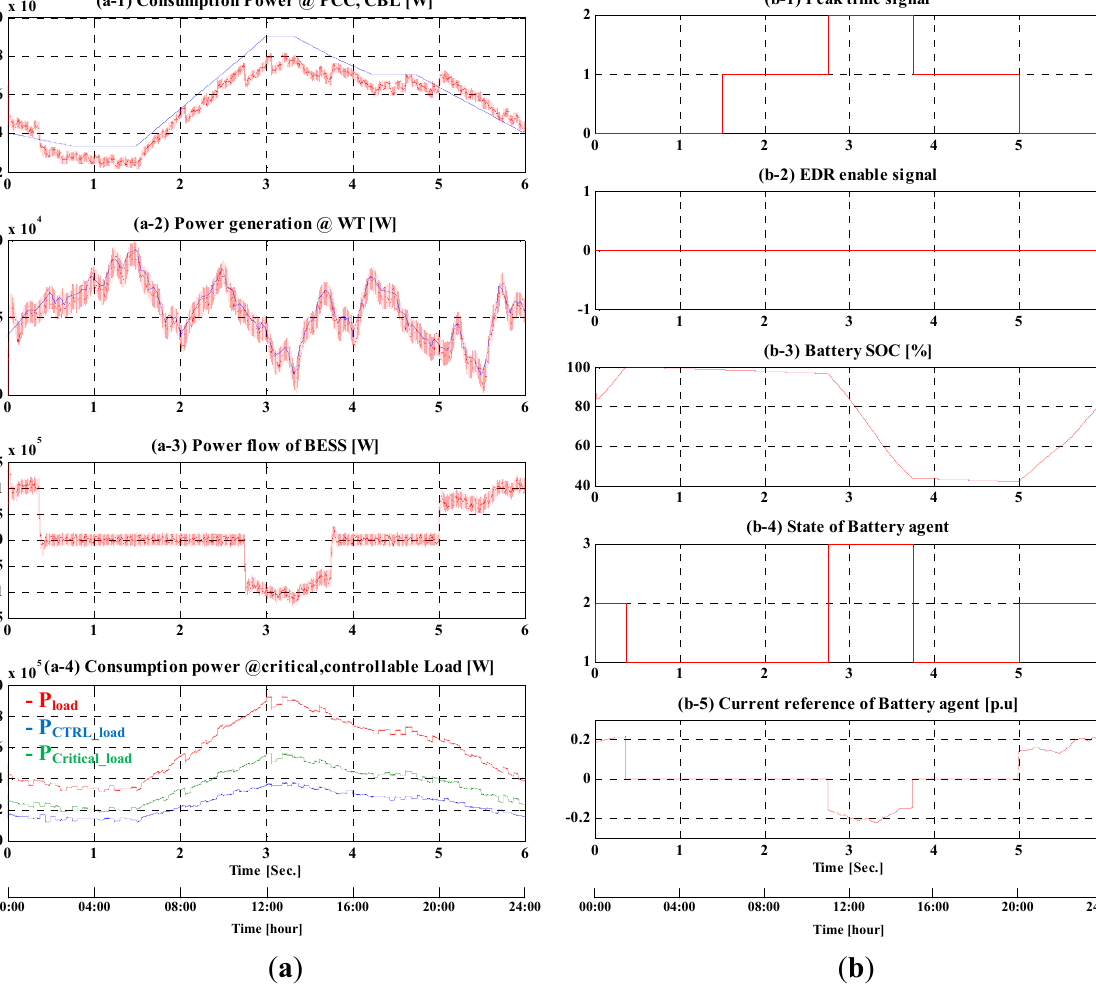
Figure 13. Simulation results in case 1. ( a ) Power flow of microgrid; ( b ) Signal process of battery